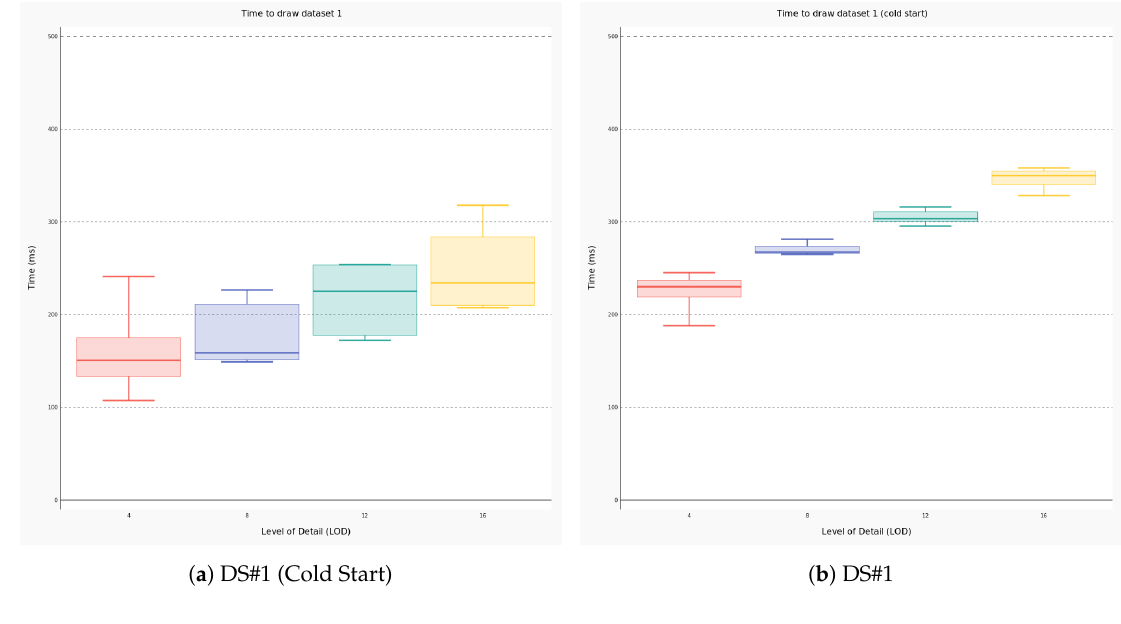
Figure 18. Time to represent DS#1.